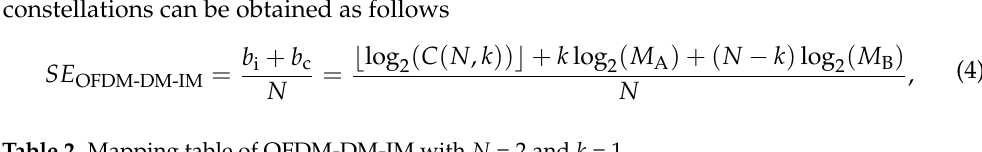
Table 2. Mapping table of OFDM-DM-IM with N = 2 and k =